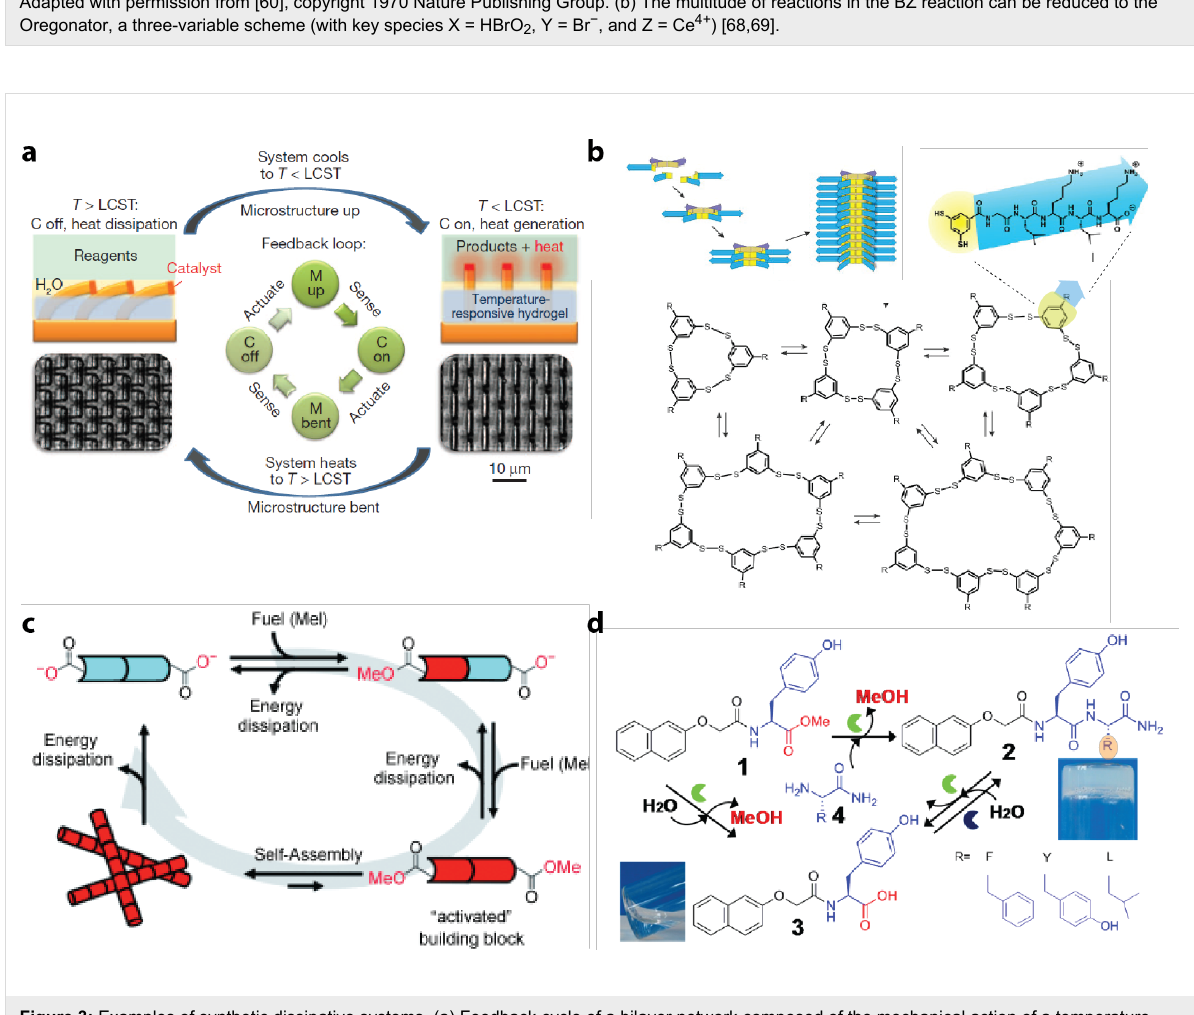
Figure 3: Examples of synthetic dissipative systems. (a) Feedback cycle of a bilayer network composed of the mechanical action of a temperature- responsive gel coupled with various exothermic reactions. Reprinted with permission from [34], copyright 2012 Nature Publishing Group. (b) Small dynamic combinatorial library made from dithiol building blocks. Adapted with permission from [75], copyright 2013 American Chemical Society. (c) Self-assembly fibrous structures fueled by molecular gelators. Reprinted with permission from [76], copyright 2010 Wiley-VCH Verlag GmbH & Co. (d) Biocatalytic self-assembly in the presence of chymotrypsin (green) forming hydrogelators that can be modified by the choice of amino acids depicted in the bottom right side. Reprinted with permission from [77], copyright 2013 American Chemical